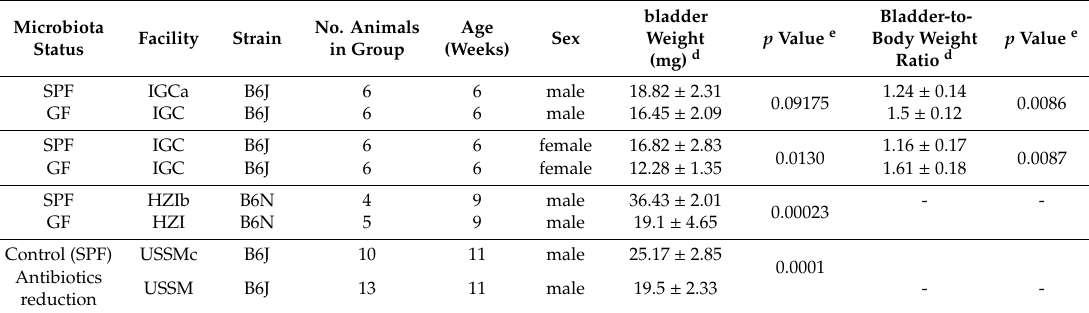
Table 2. General characteristics of analyzed mice.